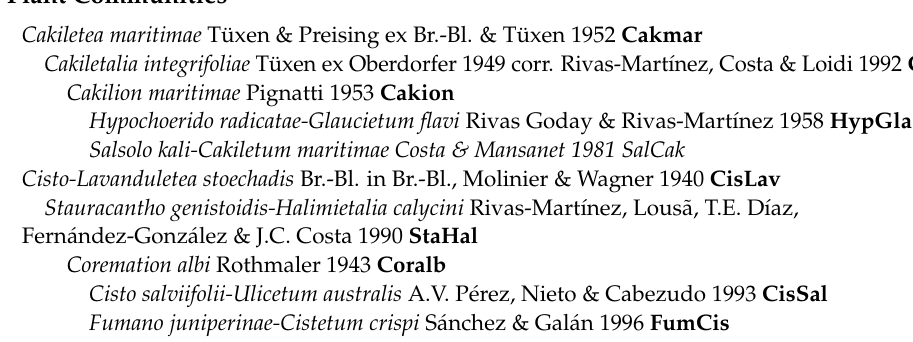
Table S2: Distribution of communities by protected